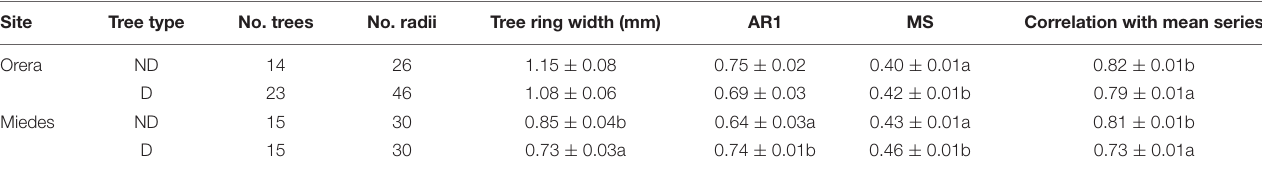
TABLE 2 | Tree-ring width (RW) data and statistics, first-order autocorrelation (AR1), mean sensitivity (MS), and correlation with mean series of D and ND trees in the Orera and Miedes study sites. Site Tree